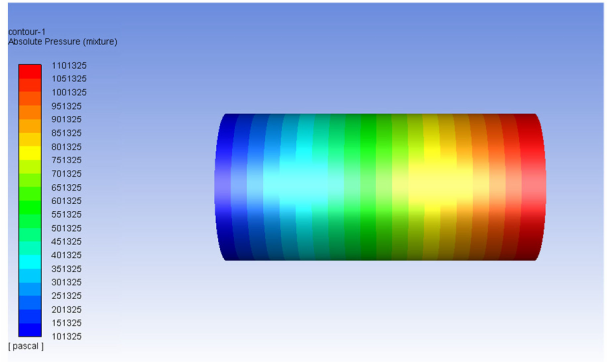
Figure 5. Pressure profile across the core after 1 s—validation